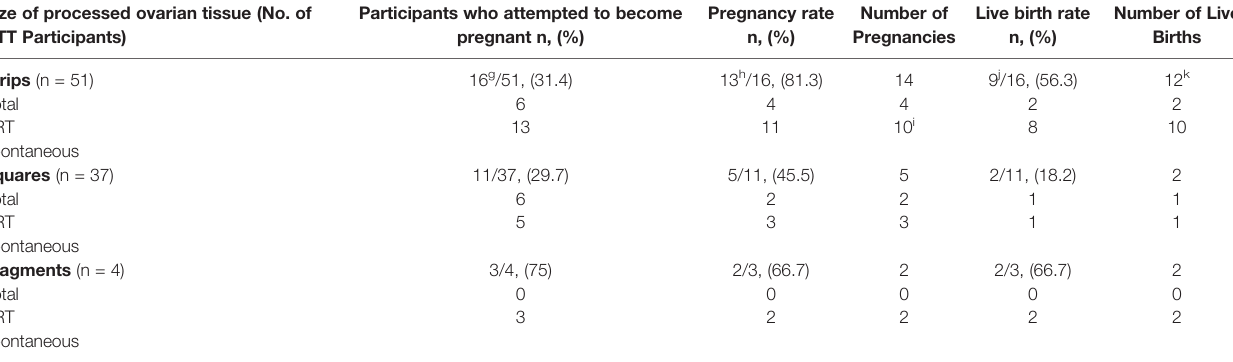
TABLE 4 | Pregnancy and live birth outcome after transplantation per 1 st transplant (21, 22, 25, 34, 37, 44, 57, 59, 61, 64, 66, 78, 84, 91 – 93, 95, 111, 115, 118, 124). Size of processed ovarian tissue (No. of OTT